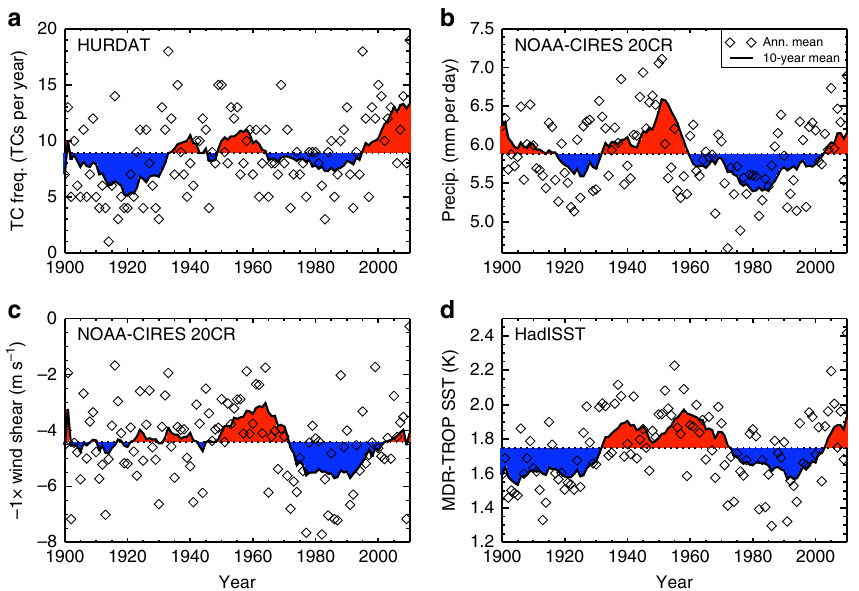
Fig. 7 Twenty- fi rst century North Atlantic climate indices from observations and reanalyses. June – November (JJASON) observations and reanalysis data time series for: a , TC frequency 29 ; b , hurricane main development region (MDR, (5° – 20°N, 15° – 85°W)) precipitation and c , wind shear 38 ; and d , sea- surface temperature (MDR minus the Tropics) 39 . Diamonds indicate JJASON average quantities for each year in the MDR or North Atlantic basin, and thick black lines denote 10-year moving averages. Red (blue) regions indicate where moving averages are above (below) the 1900 – 2010 mean values